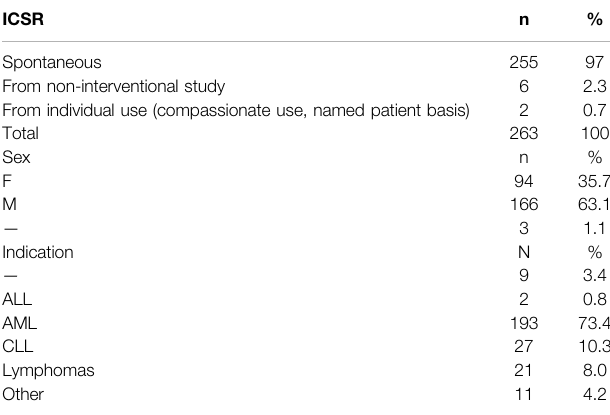
TABLE 4 | Adverse drug reactions reported in Italy from venetoclax approval in 2017. ICSR n % Spontaneous